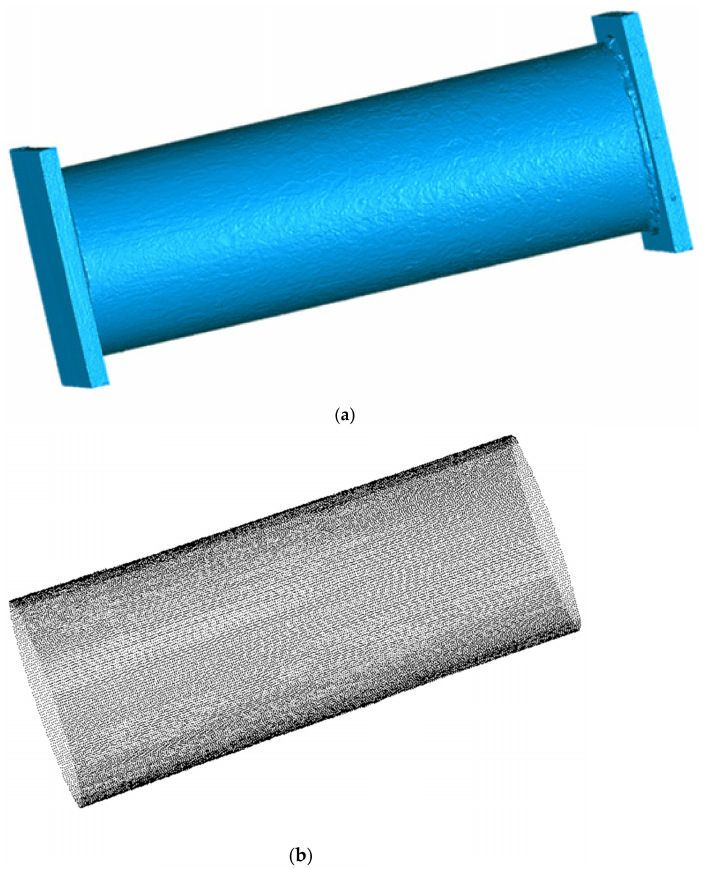
Figure 4. Surface profile and coordinate data obtained from 3D scanning results: ( a ) surface profile; ( b ) coordinate data.